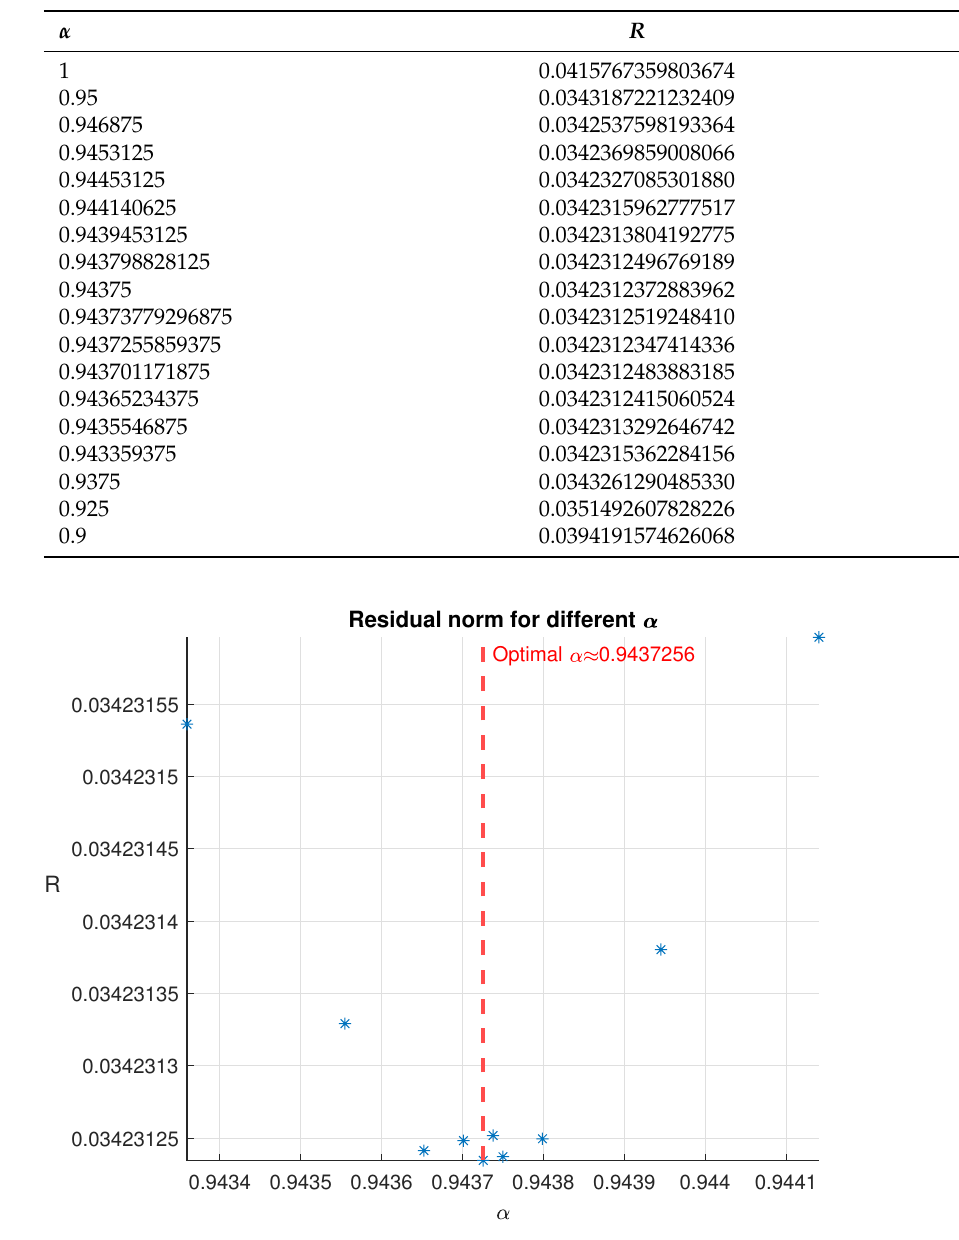
Figure 10. The residual norm (13) for different values of α